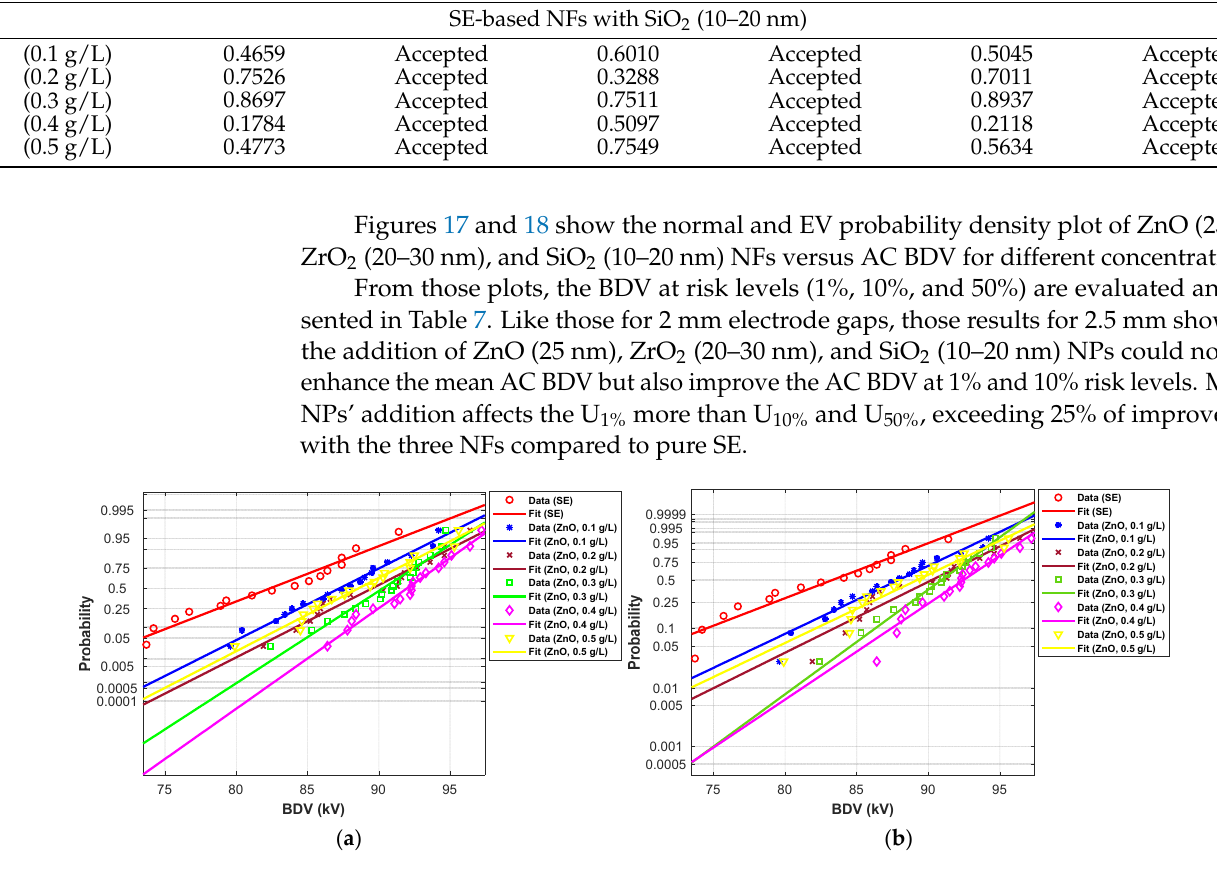
Figure 17. Probability plot of breakdown voltage data of SE-based nanofluids with ZnO (25 nm) for 2.5 mm electrode gaps; ( a ) normal and ( b ) extreme value.